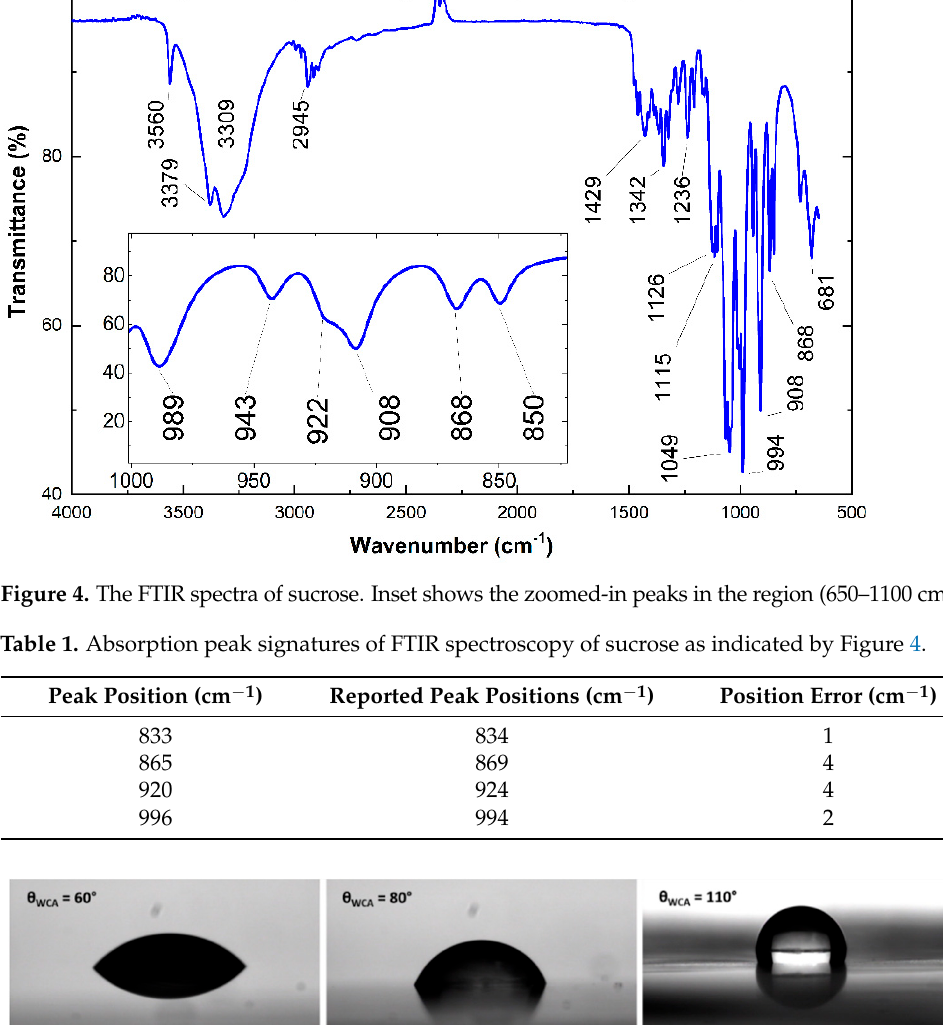
Figure 4. The FTIR spectra of sucrose. Inset shows the zoomed-in peaks in the region (650–1100 cm − 1 ).